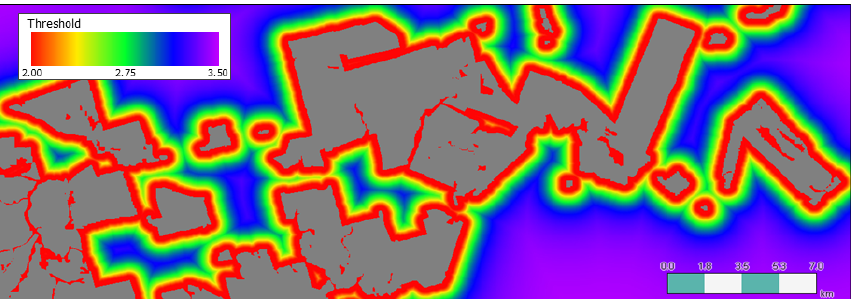
Figure 6. Example of variable threshold map, built as a logistic accumulated probability function. Grey areas represent past deforestation. Notice how the threshold values increase with the distance to past